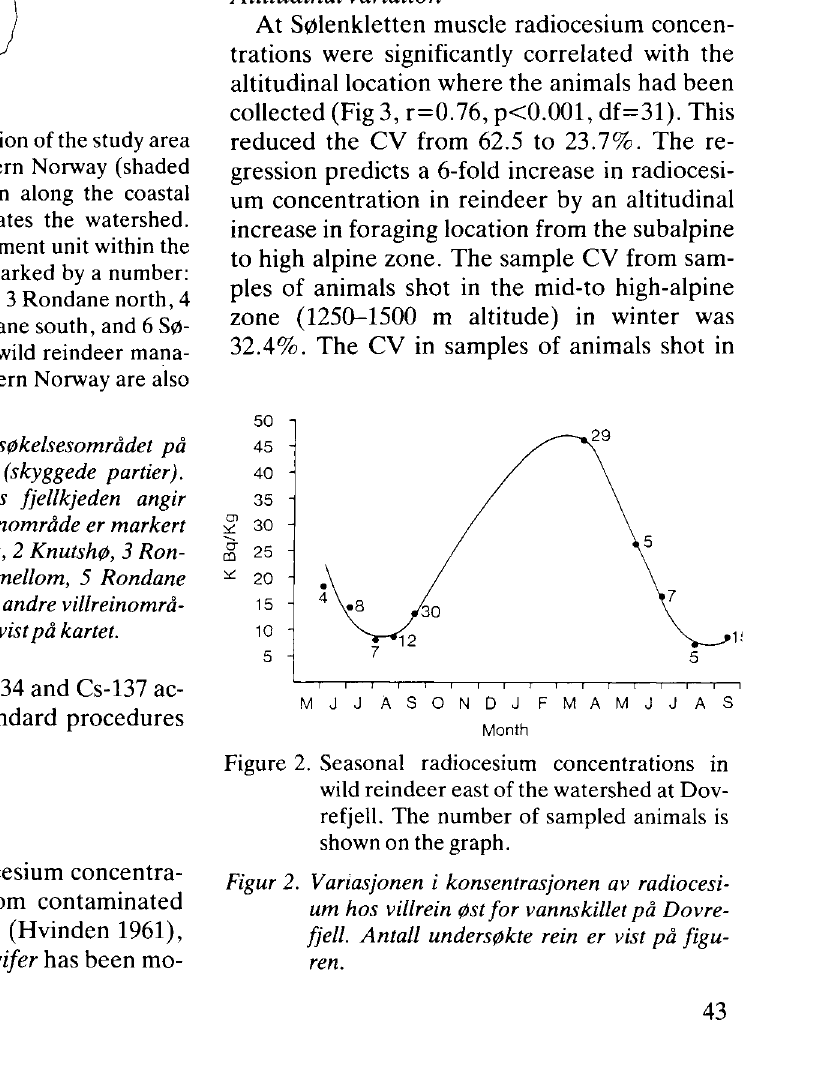
Figure 1. The geographical location of the study area at Dovrefjell in southern Norway (shaded parts). The line drawn along the coastal mountain range indicates the watershed. Each reindeer management unit within the shaded study area is marked by a number: